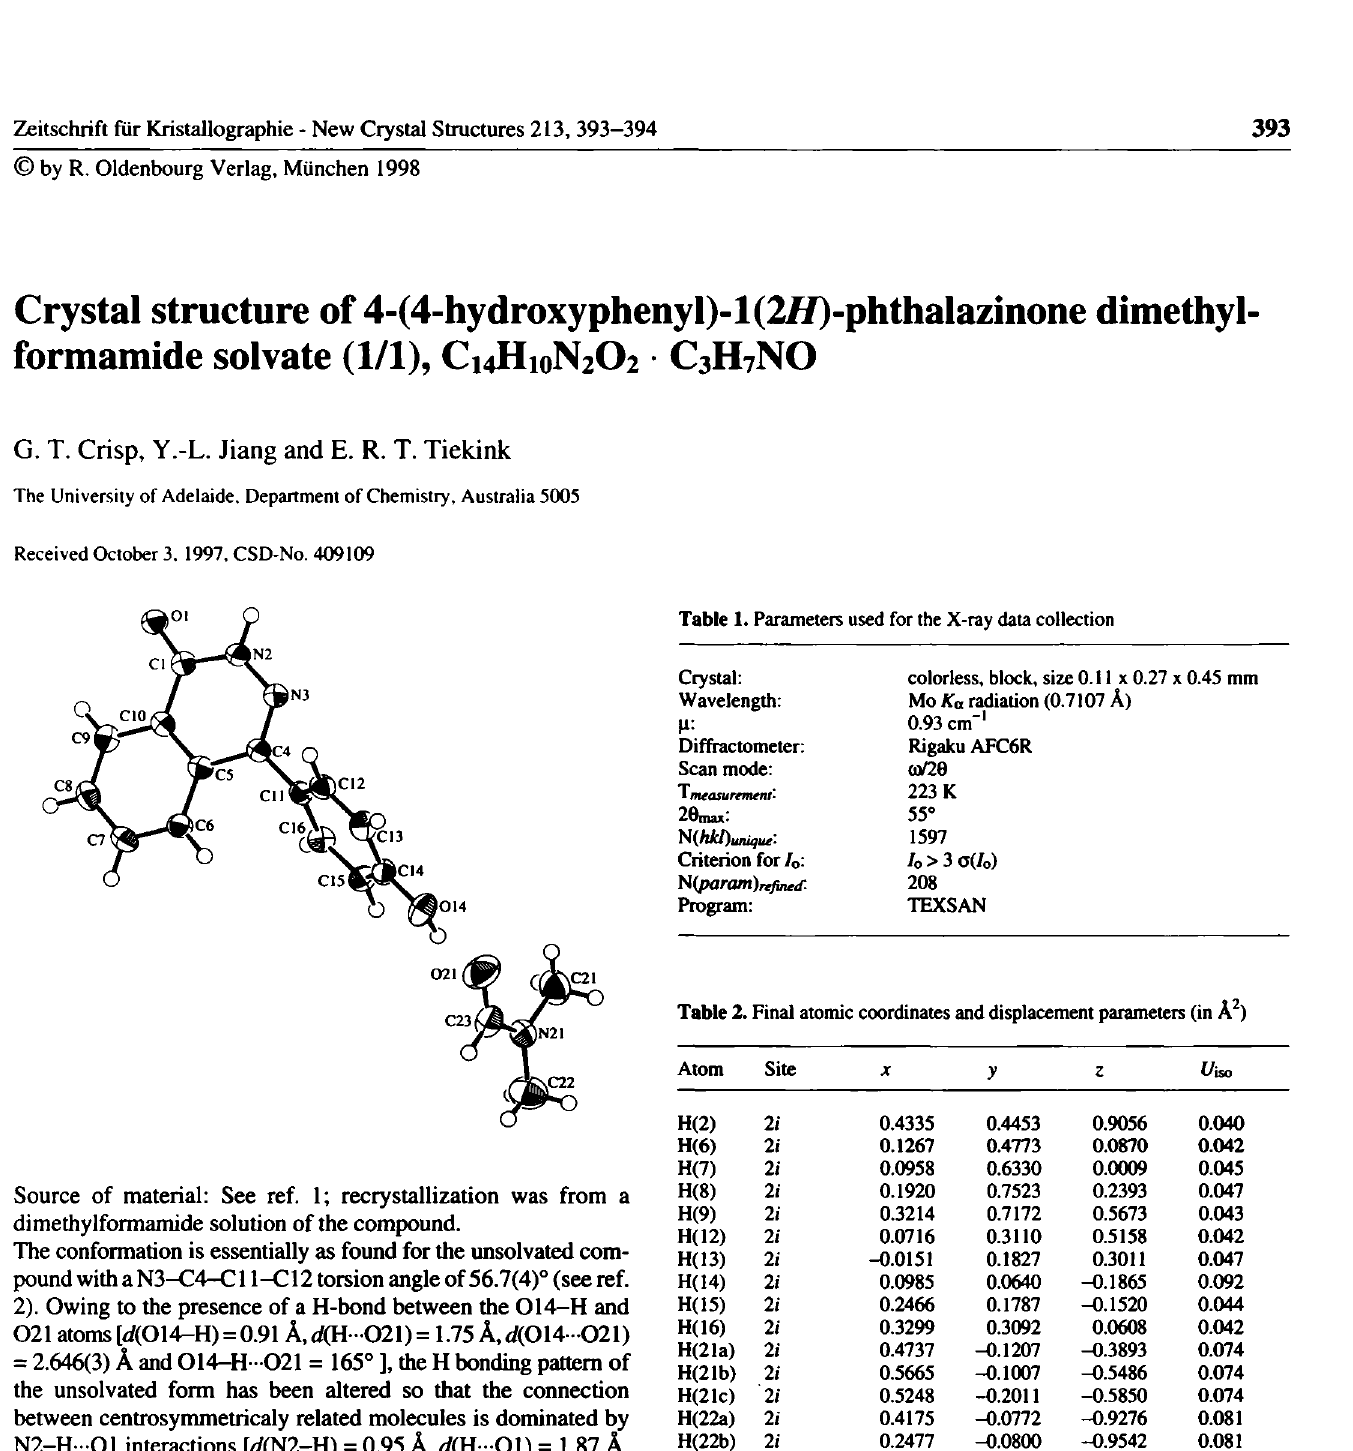
Table 3. Final atomic coordinates and displacement parameters (in À^)